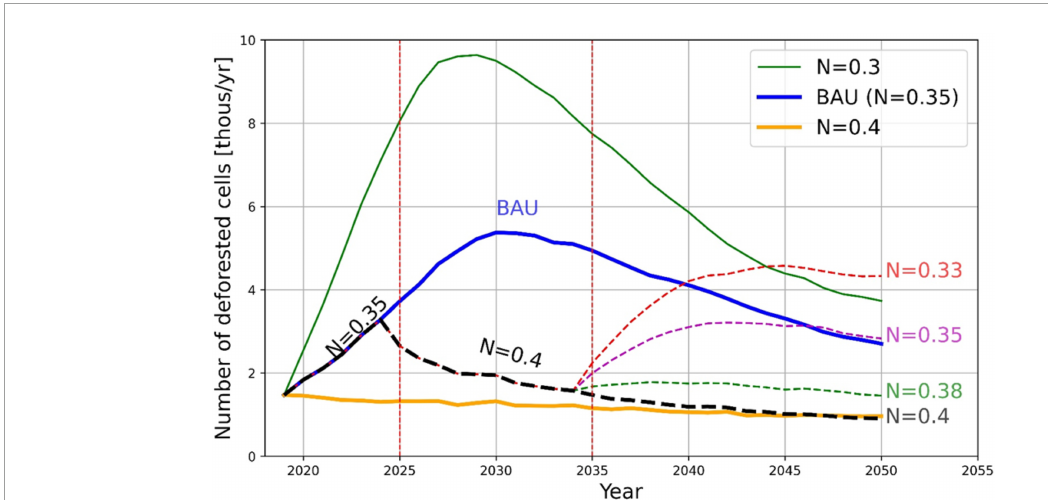
FIGURE9 Deforestation scenarios under jurisdictional policies.